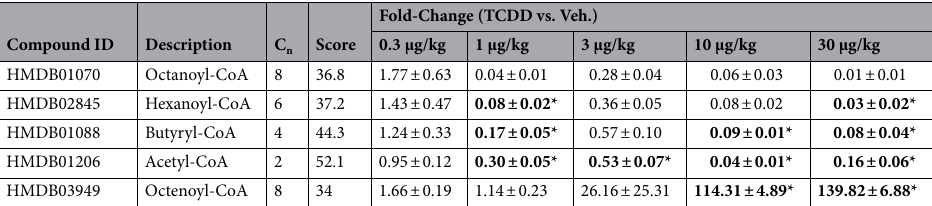
Table 1. Effect of TCDD on acyl-CoA levels. Acyl-CoA levels were assessed using untargeted liquid chromatography tandem mass spectrometry. Mice (n = 4–5) were orally gavaged every 4 days for 28 days with sesame oil vehicle or TCDD. Fold-changes were calculated for each treatment group relative to the vehicle control group. Bold font and asterisks ( * ) denote statistical significance ( p ≤ 0.05) determined using a one-way ANOVA with a Dunnett’s post-hoc analysis. Scores were determined by Progenesis with 60 being the maximum value and 0 being the minimum value. Scores ranging from 30 to 40 are based on mass error and isotope distribution similarity, while score > 40 are based on mass error, isotope distribution and fragmentation score. All annotated compounds have a score distribution averaging ~